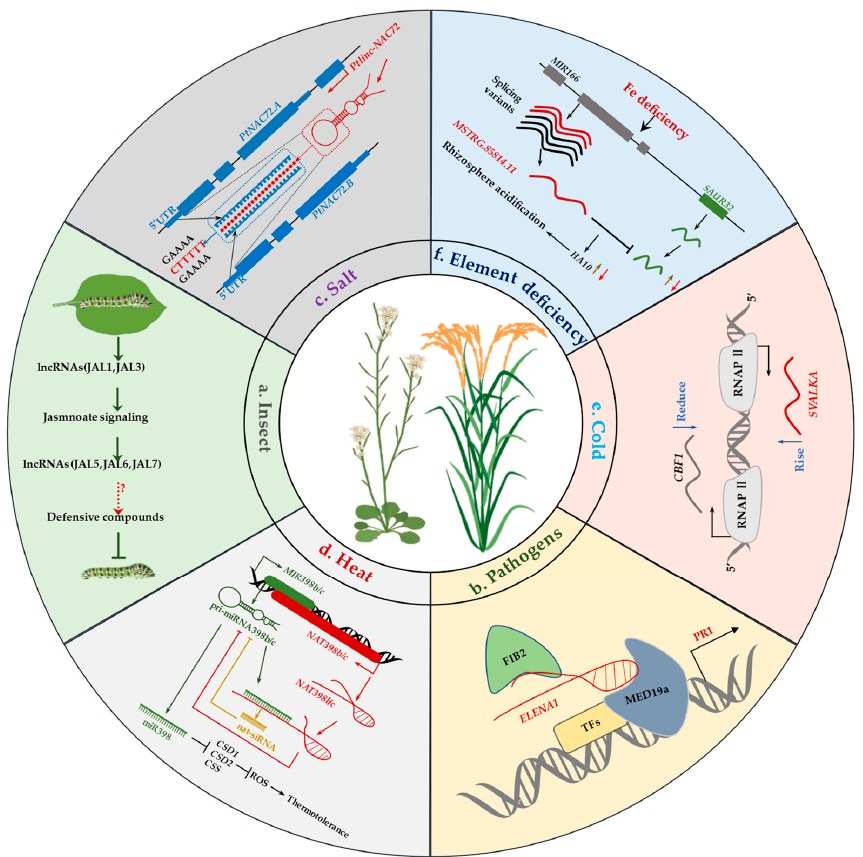
Figure 5. Mechanisms of lncRNAs in response to external pressure. ( a ) JA signaling is regulated by lncRNAs (such as JAL1 and JAL3) in response to early plant attack by diamondback moth [38]. ( b )